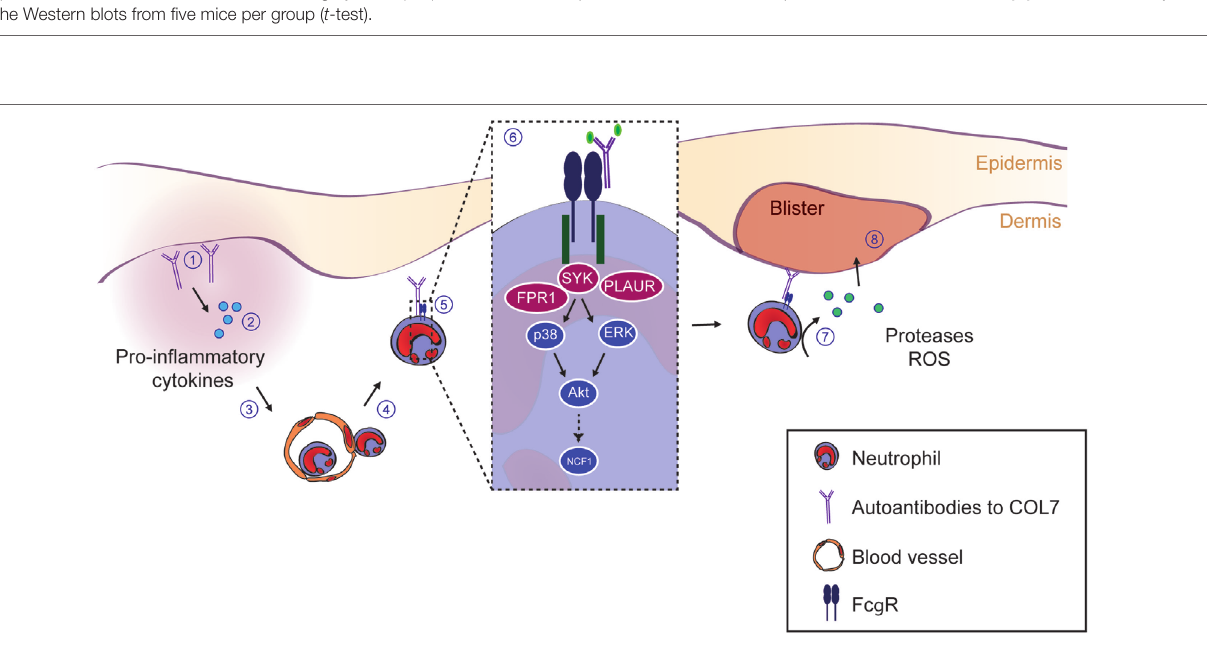
FigUre 9 | SYK and downstream kinases are essential to drive inflammation and blistering in experimental epidermolysis bullosa acquisita (EBA). This schematic summarizes the current understanding of the events leading to blistering in experimental EBA. (1) The initial event is the binding of the IgG and/or IgA autoantibodies directed against type VII collagen (COL7). (2) Thereafter, anaphylatoxins are generated by activation of the complement cascade. Furthermore, several cytokines lipid mediators are released, which collectedly leads (3) to the activation of endothelial cells and allows the (4) CD18/ICAM-1-dependent extravasation of Gr-1 + myeloid cells into the skin. (5) Within the skin, myeloid cells bind to the skin-bound immune complexes via specific activating Fc gamma receptors (Fc γ R). (6) Fc γ R binding triggers an intracellular signaling cascade involving SYK, p38, ERK, and Akt, ultimately leading to the activation of the NCF1 gene, which is part of the NADPH oxidase complex and generates reactive oxygen species (ROS). Within this pathway, we show an absolute requirement of SYK for blister induction in EBA. Blockade of downstream kinases (i.e., p38, Akt, or individual Src family kinases) only partially reduces the blistering phenotype, indicating that SYK activation is in the center stage of EBA pathogenesis. (7) Ultimately, this intracellular signaling process leads to the release of ROS and proteases from the myeloid cells, which (8) mediates blistering. Image modified from Ludwig et al.